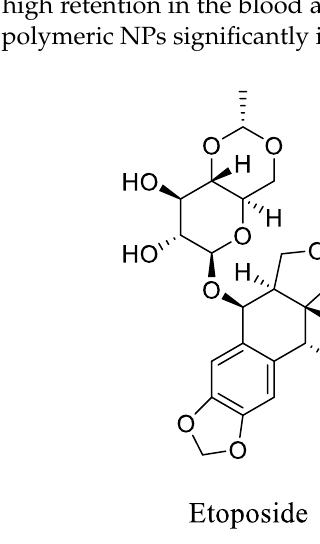
Figure 11. Schematic diagram of Etoposide-loaded PLGA and PCL nanoparticles and chemical structure of Etoposide [60].